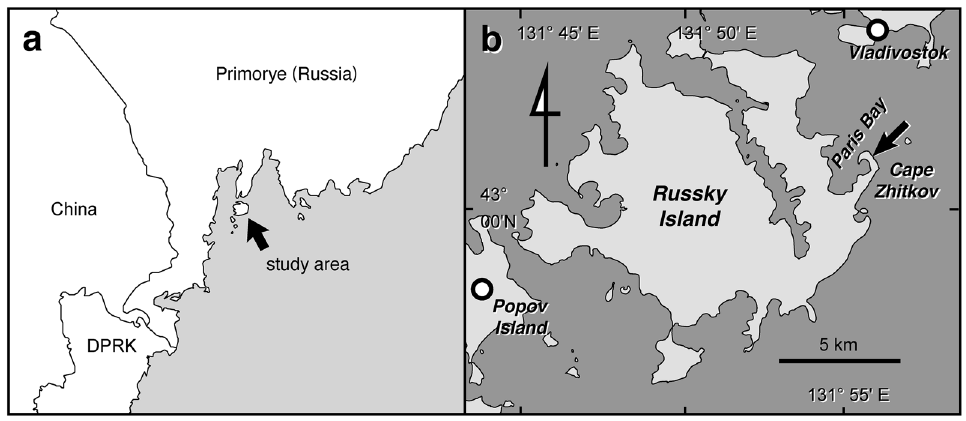
Figure 2. Locality map. (a) Location of the study area on Russky Island in the Russian Far East. (b) Locality of Cape Zhitkov. The exact site of NSM PV 23854 and 24995 is marked by an arrow. This map is created using Adobe Illustrator ver. 26.1 (https:// www. adobe.